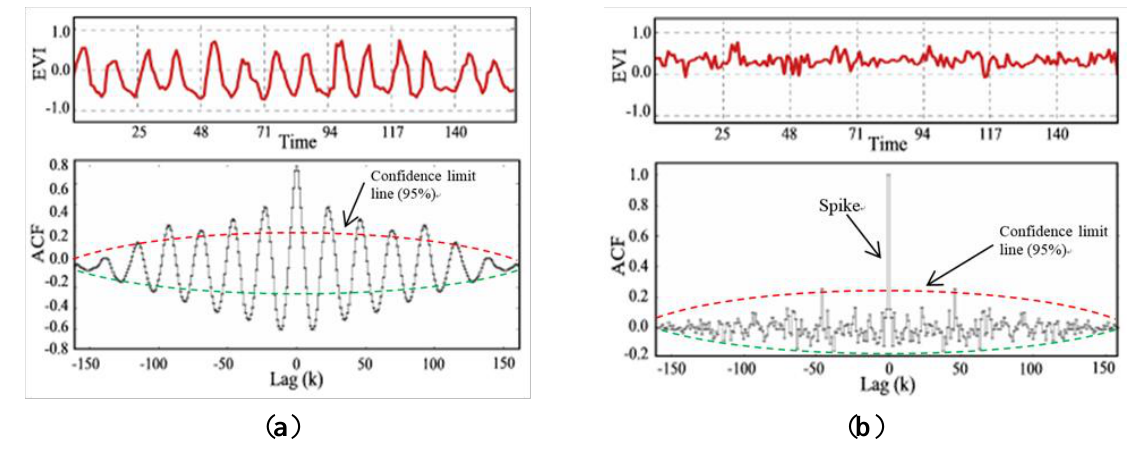
Figure 5. The correlogram graphs. ( a ) Periodic pattern and ( b ) Non-the periodic